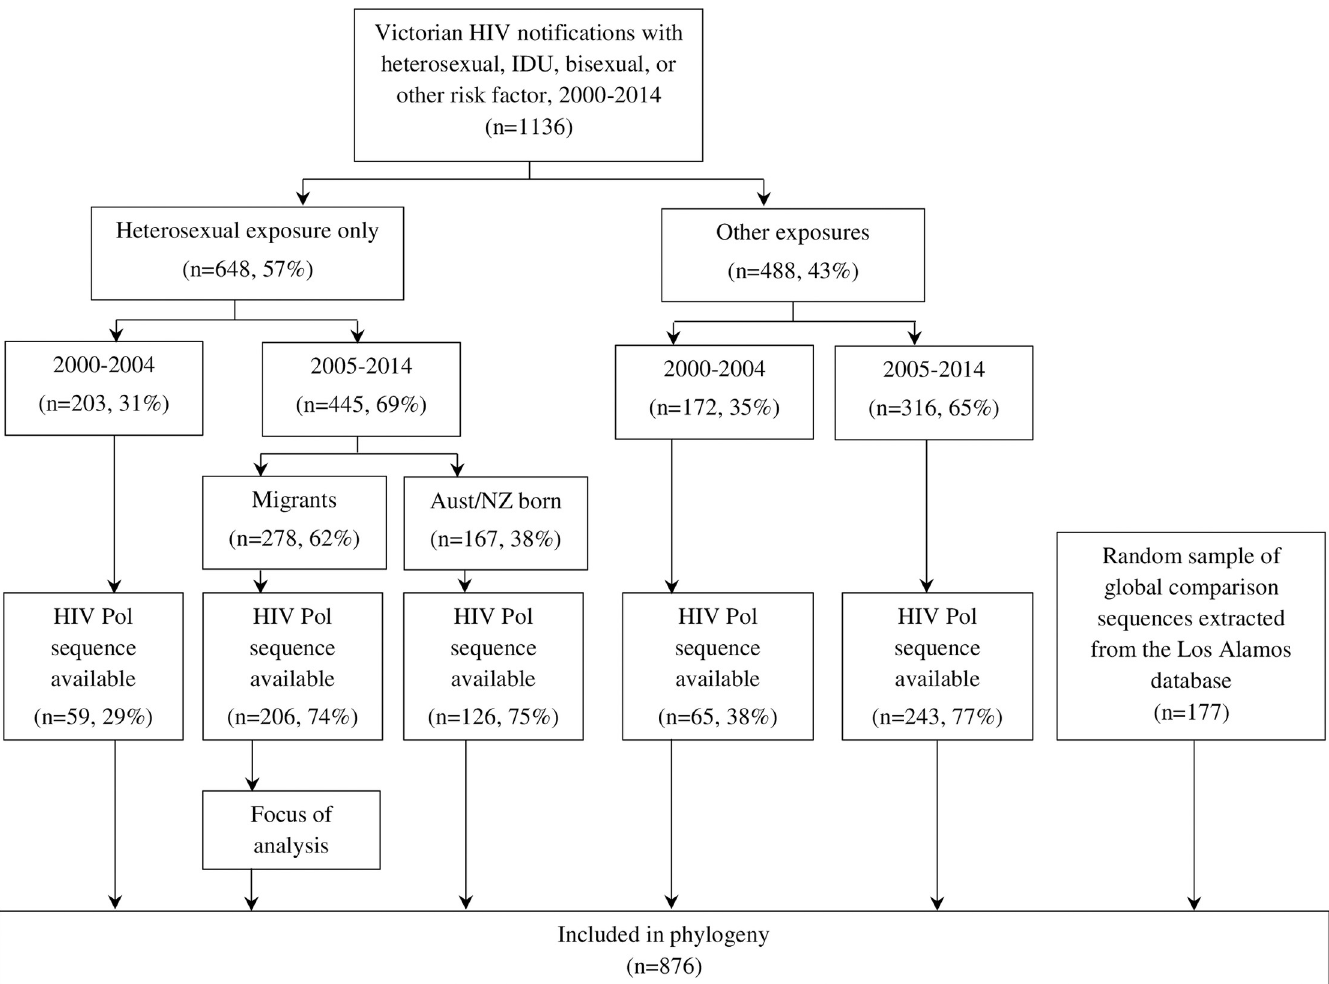
Fig 1. Flow chart of study